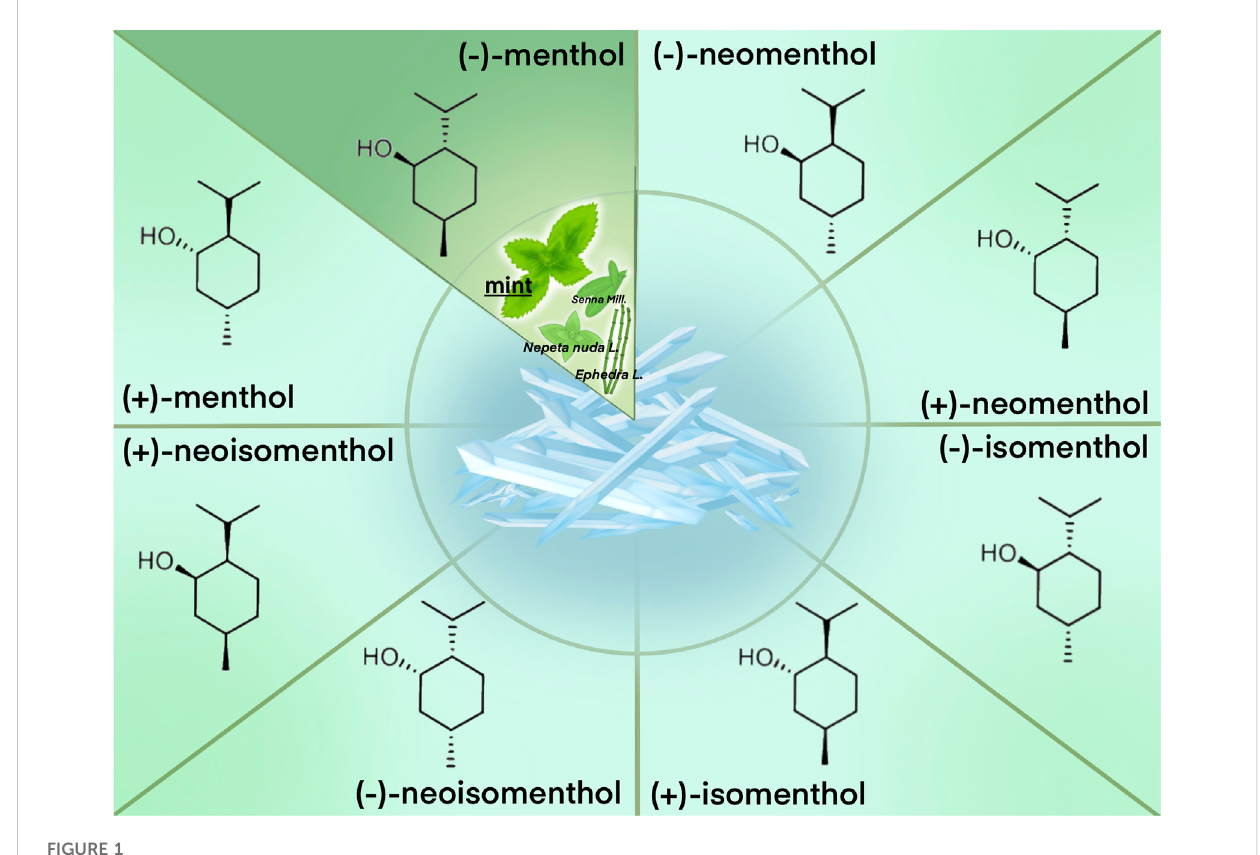
FIGURE 1 Plant sources of menthol and isomer ’ s